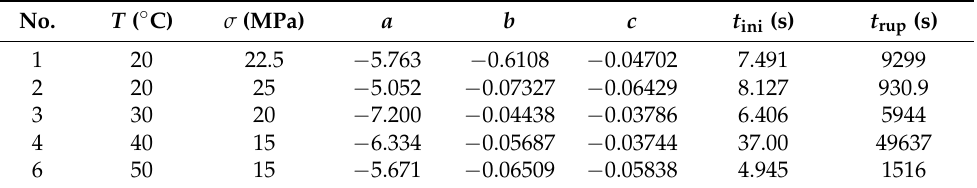
Table 2. Results of model fitting parameters ( a , b , c ) using Equation (5). The initial and rupture times are directly obtained from the raw testing data. The numbers in the first column corresponds to the test condition in Table